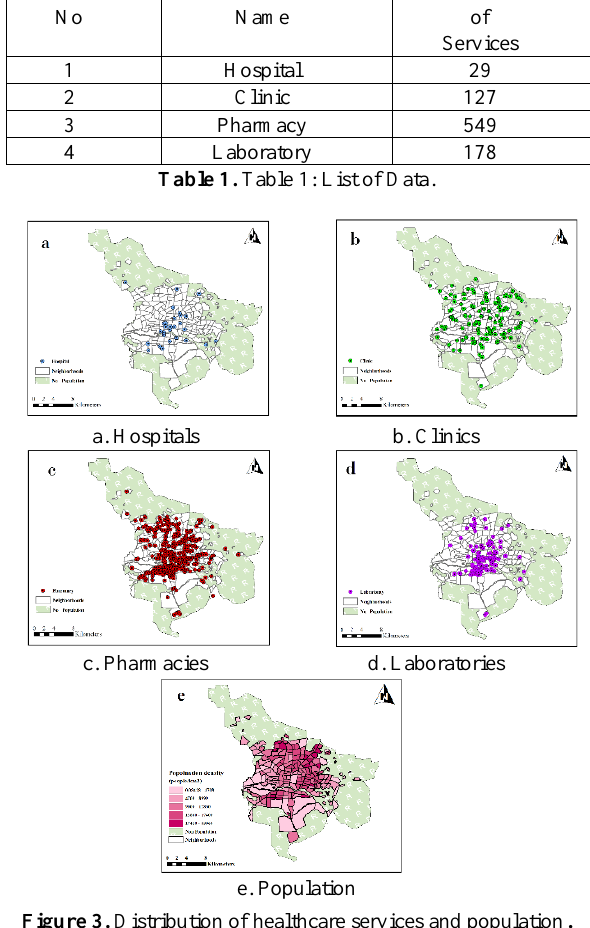
Figure 3. Distribution of healthcare services and population